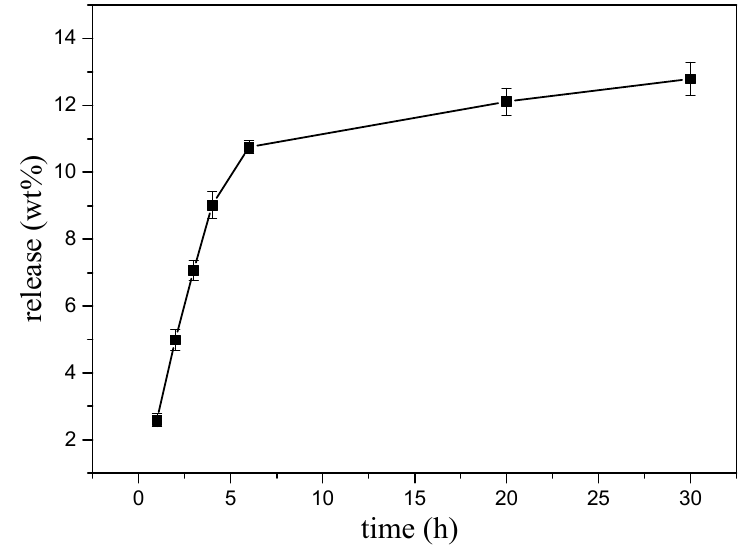
Figure 10. Slow-release curve of ass-ABMP in phosphate-buffered saline (PBS) solution. The test was executed three times under the same conditions.